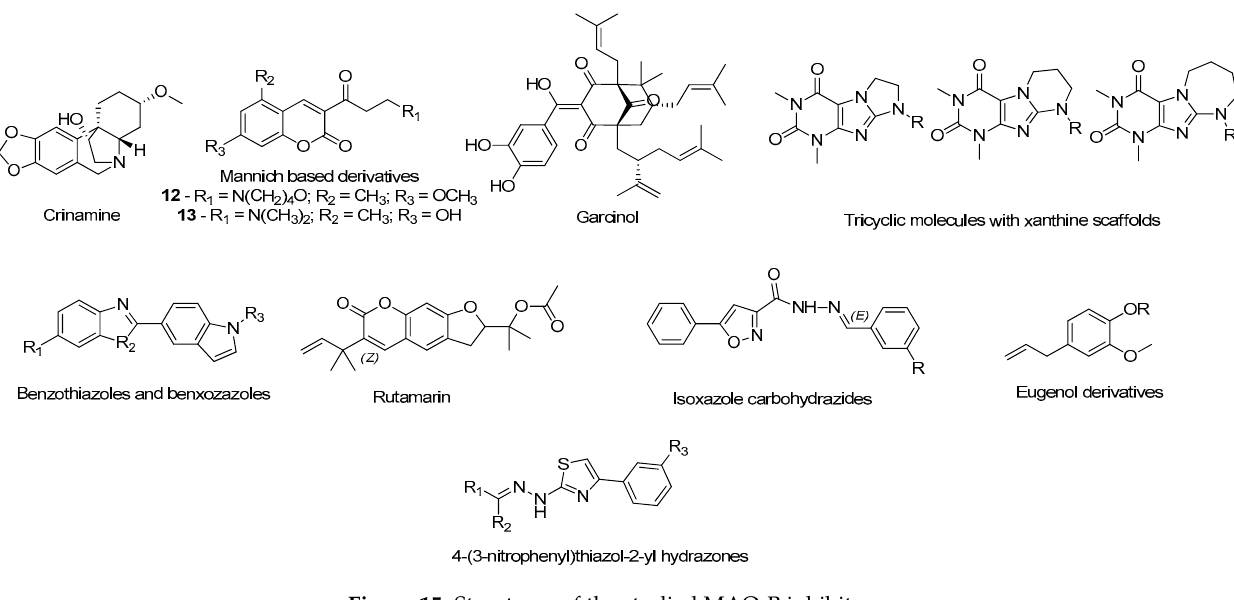
Figure 15. Structures of the studied MAO-B inhibitors.